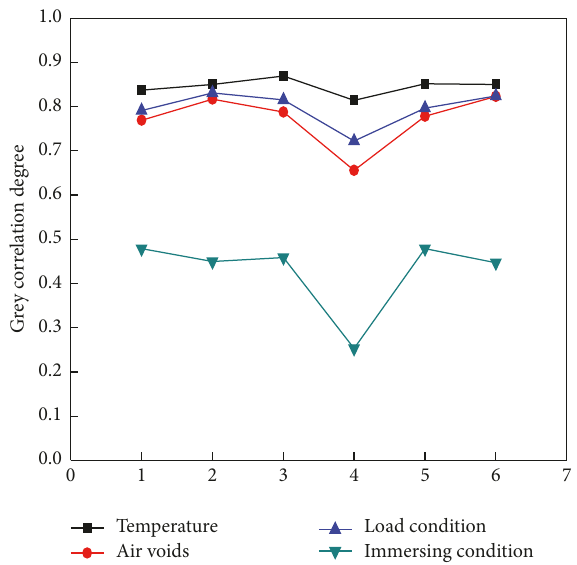
Figure 14: Grey correlation degrees of temperature, air void, load, and immersing condition.